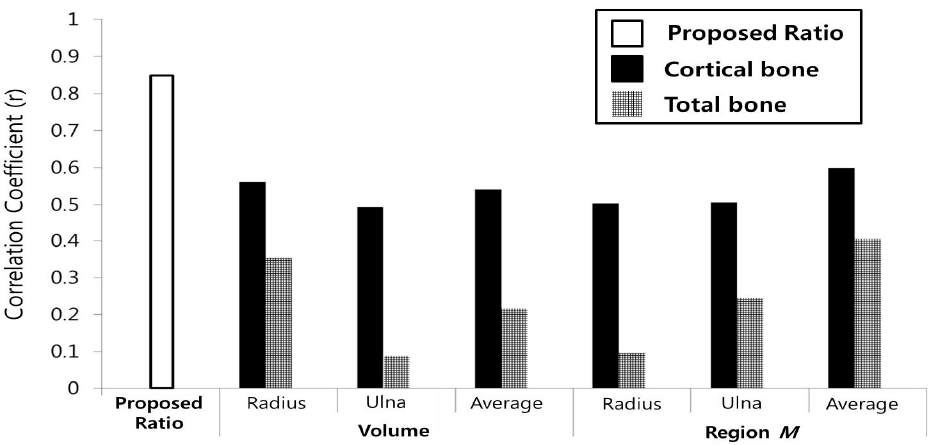
Figure 7. Comparison of correlation coefficient values according to volumes and areas in different sites.